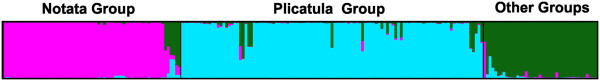
STRUCTURE analysis for the 214Paspalumaccessions. A bar plot obtained from a model-based ancestry analysis of the 214 Paspalum accessions implemented within the STRUCTURE software.